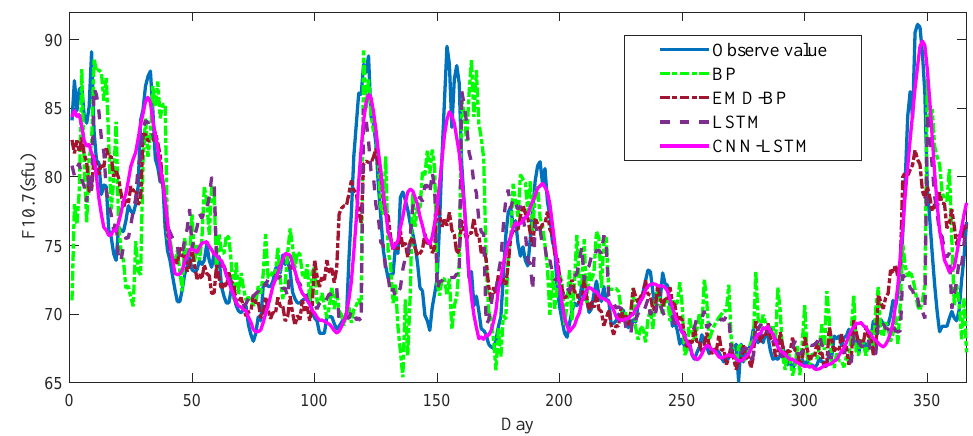
Figure 5. The fitting curves of 10-day forecasts in 2007.